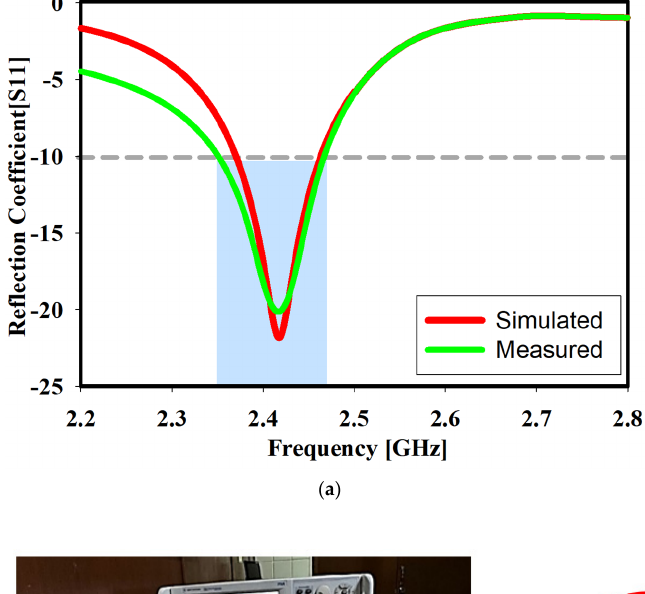
Figure 7. Performance comparison between the basic meander line antenna with the proposed design. Prior to the selection and fabrication of a final structure, numerous essential parameters of the proposed antenna are analyzed to show better performance in terms of single ‐ band operation, bandwidth, and compact size.